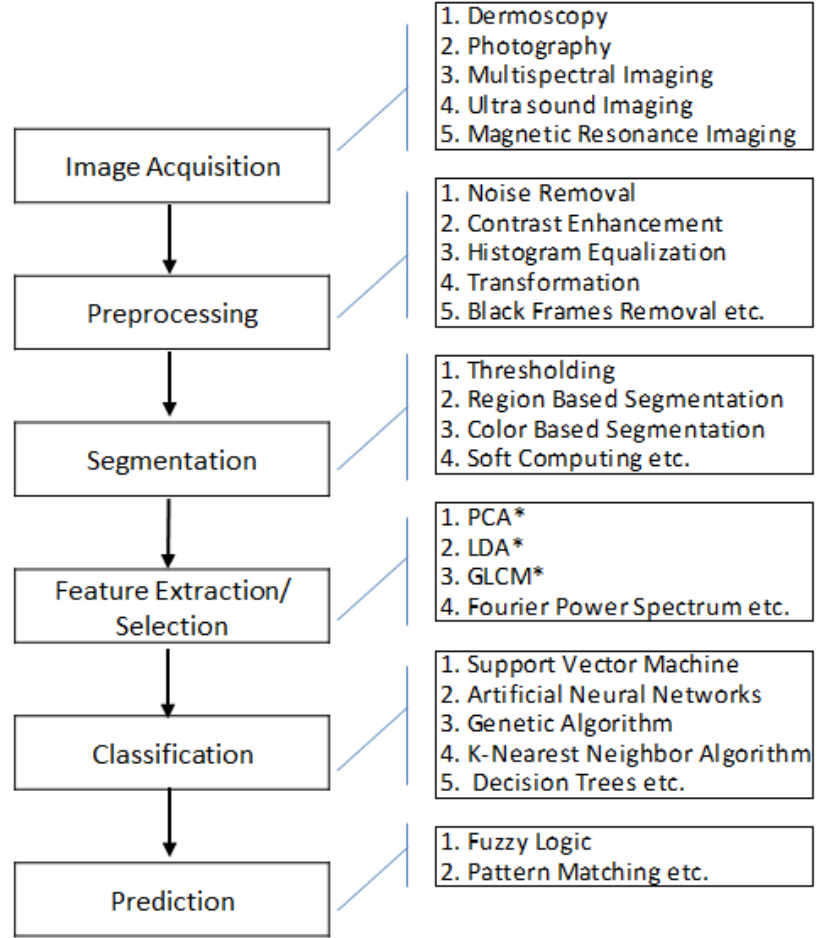
Figure 1. Workflow of the CAD system . * is to highlight the